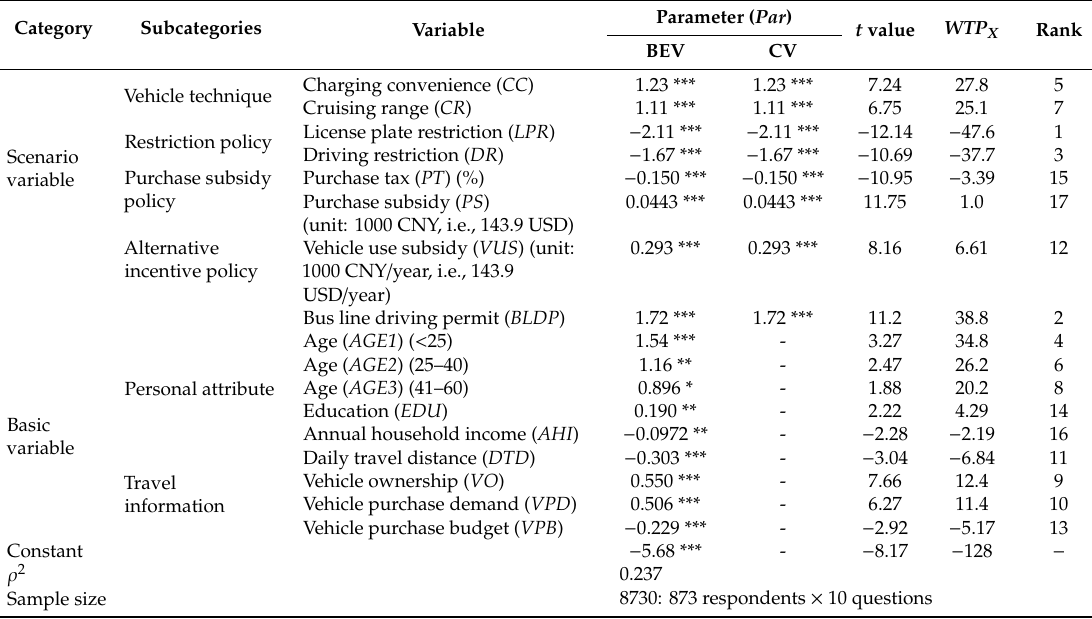
Table 4. Parameter estimation results of the BL